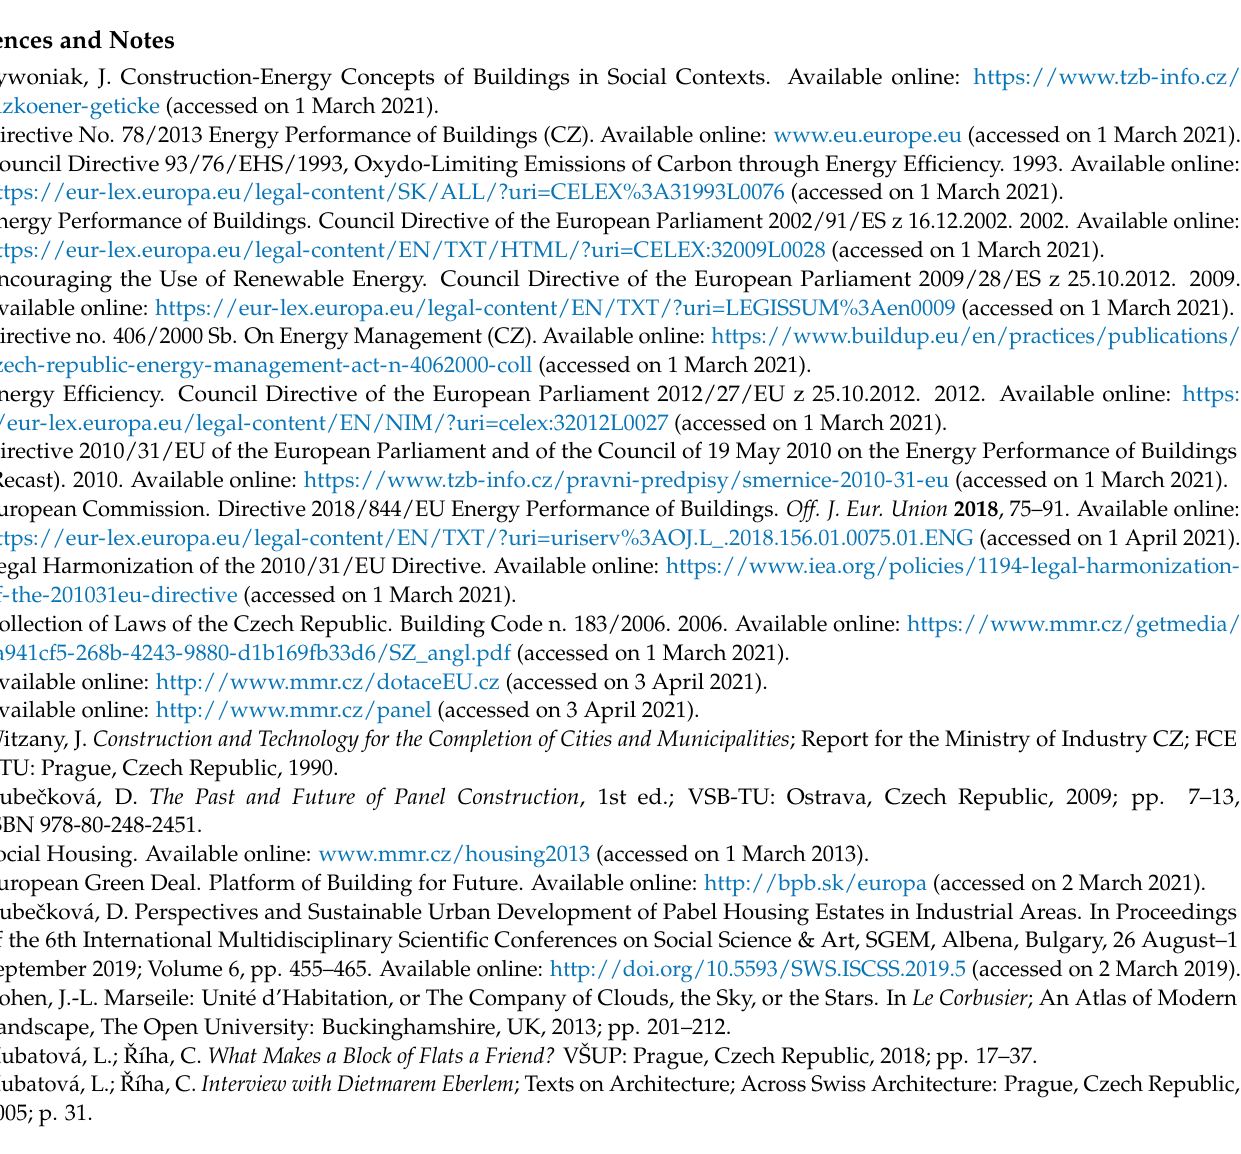
Figure A4. Development trends in the application of additional contact thermal insulation shown with an example of a prefab panel system of a residential housing building in the type series T06B-OS: ( a ) Prefab building in its original state; ( b ) lamellar contact design; ( c ) prefab residential housing building after application of ETICS.